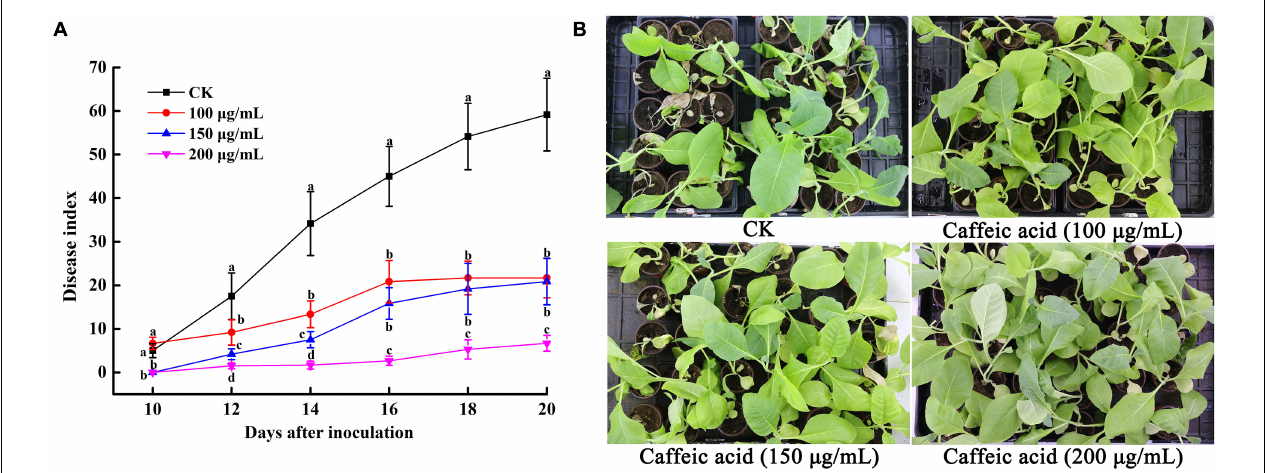
FIGURE 8 | Disease index of tobacco bacterial wilt CA treatment (A) . Disease symptoms of representative tobacco seedlings inoculated with R. solanacearum for 20 days (B) . Unwounded tobacco plants were soil-soak inoculated at concentrations of 5 mL (1 × 10 8 CFU/mL) and inoculated at 28 ± 1 ◦ C after treatment with 100, 150, 200 µ g/mL PCA. Untreated plants were treated with sterile water. The bars indicate the standard error of the mean of three replicates. The lowercase letters indicate significant differences identified according to Duncan’s test ( p < 0.05).